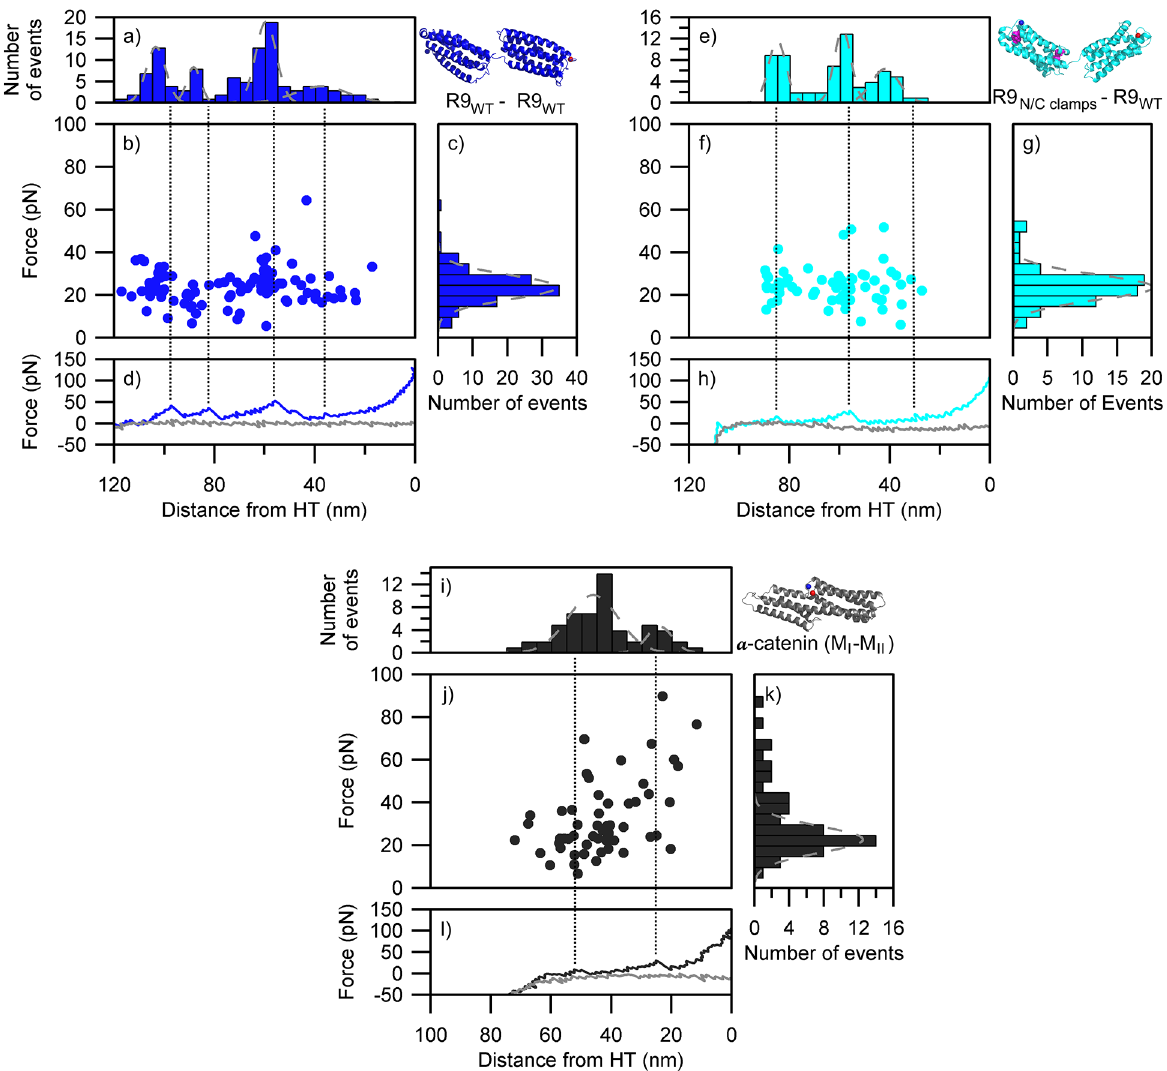
Fig 5. Unfolding patterns of tandem α -helical bundles as determined by smAFM. (a-d) Talin R9 (wt)–R9 (wt) (47 traces). (e-h) R9 (N/C- clamps)–R9 (wt) (34 traces). (i-l) α -catenin (M I -M II ) (40 traces). (a, e & i) length histogram indicating the distance from unfolding event to HaloTag standard; (b, f & j) scatter plot showing force vs position for all unfolding events; histogram the force associated with unfolding events; (d h & l) representative force extension retraction curve (blue, cyan & black line) showing how the unfolding events relate to scatter plot and length histogram (black dotted line), gray line represents approach curve for AFM tip. Gray dotted lines on (c, g & k) histograms represent Gaussian fits.